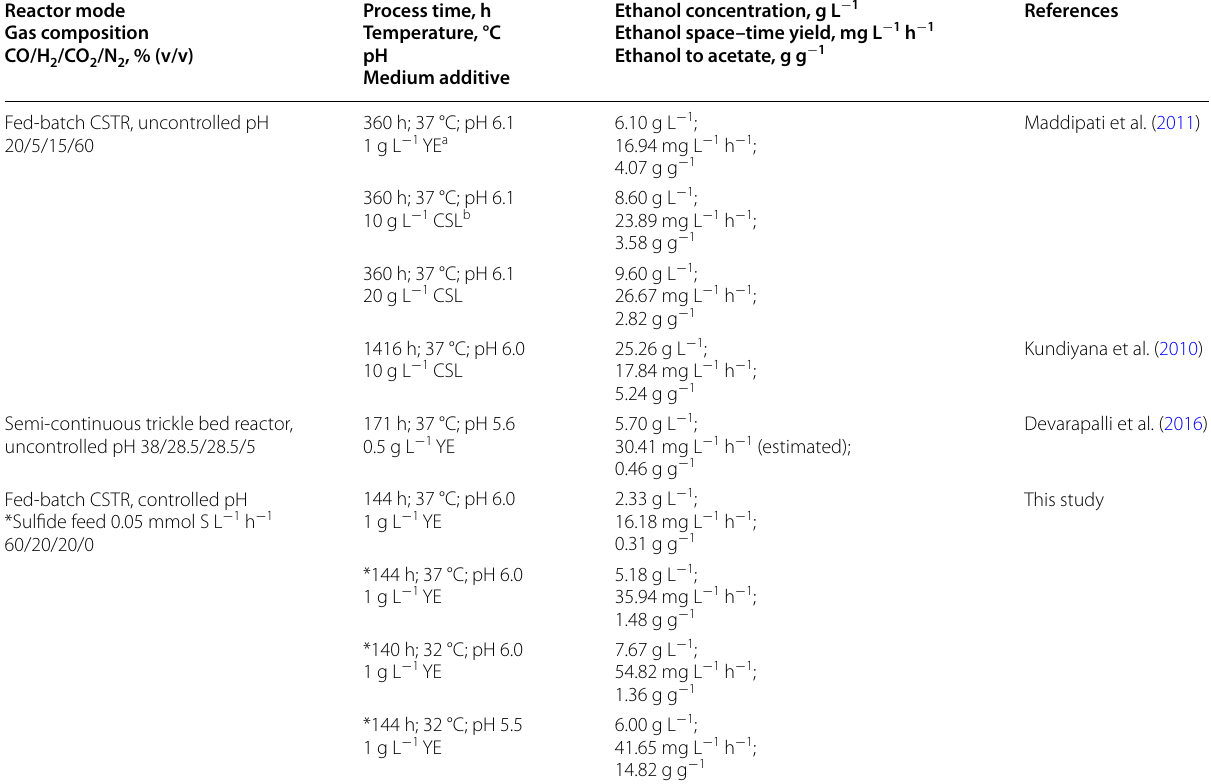
Table 1 Comparison of final ethanol concentrations, total ethanol space–time yields, and ethanol‑to‑acetate ratio in autotrophic processes with C.